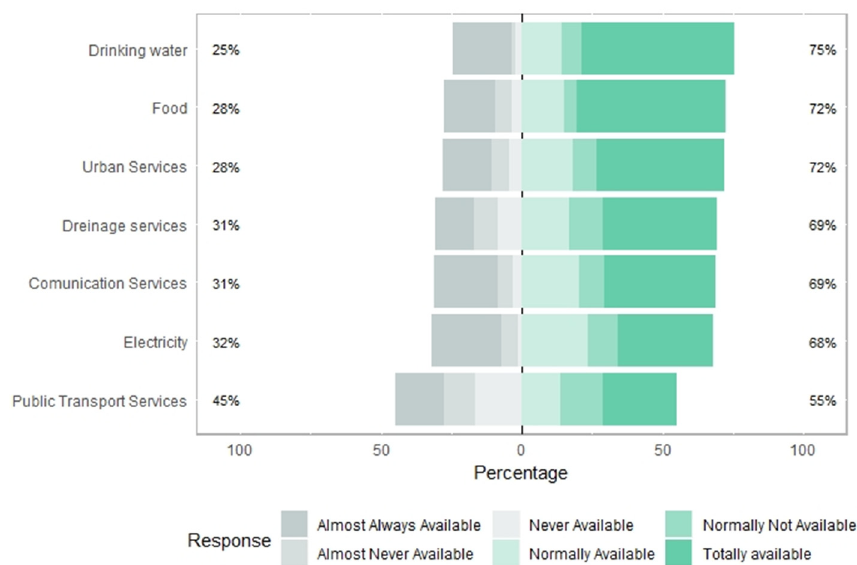
Figure 5. Centered bar plot generated with Likert with response distributions grouped by perceived availability of drinking water, food, urban services, drainage services, communication services, electricity and public transport services before a flood occurs and, if necessary, after it has occurred.